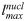
Effects of cytoskeleton, nucleus and viscosity on whole cell model mechanics.(a-c) The simulation results for the effect of the cytoskeleton filaments number density Nfil on elastic modulus (orange) and velocity (green) of small, medium and large size cells. (d) Influence of the cross-links NCL to filaments Nfil density ratio on elastic modulus (orange) and on velocity (green). (e) Influence of elastic modulus on the velocity for the case when the stiffness is changed by varying filaments density Nfil (green) or cross-links density NCL (orange). (f) Dependence of cell elastic modulus and velocity on nuclear-cytoplasmic ratio. (g) Effect of filaments number density representing chromatin inside the nucleus on cell velocity. (h) The impact of nuclear laminar properties varied using parameter lmaxnucl in the nucleus membrane model on the cell velocity. (i) Effect of viscosity on cell velocity in microfluidic device. Error bars on all plots show standard deviation.